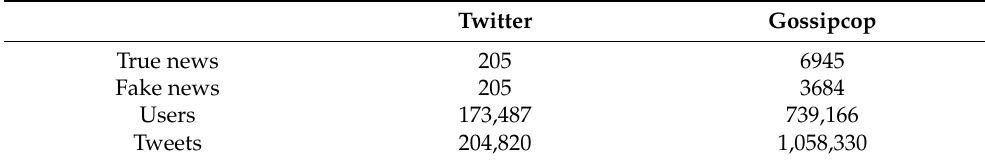
Table 1. Statistics of the